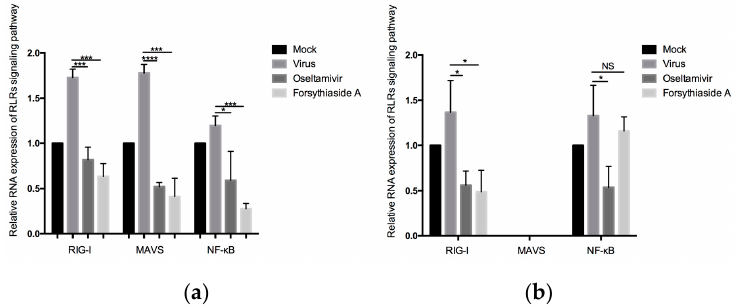
Figure 6. Relative RNA expression of retinoic acid-inducible gene-I–like receptors (RLRs) signaling pathway. ( a ) and ( b ) indicate the relative expression of retinoic acid-inducible gene-I (RIG-I), MAVS, and NF- κ B in RLRs signaling pathways of WT and MAVS − / − mice at day 6 post infection ( n = 6). * p < 0.05, ** p < 0.01, *** p < 0.001, NS, p > 0.05.